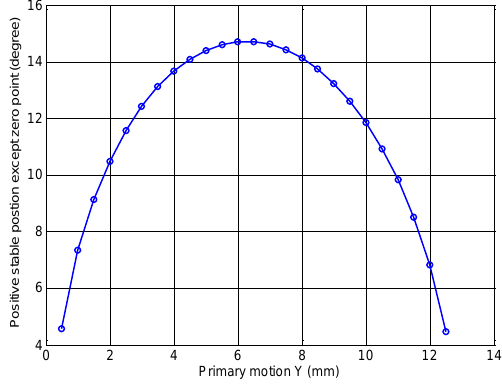
Figure 6. Positive stable rotational positions under different pri- mary motions.